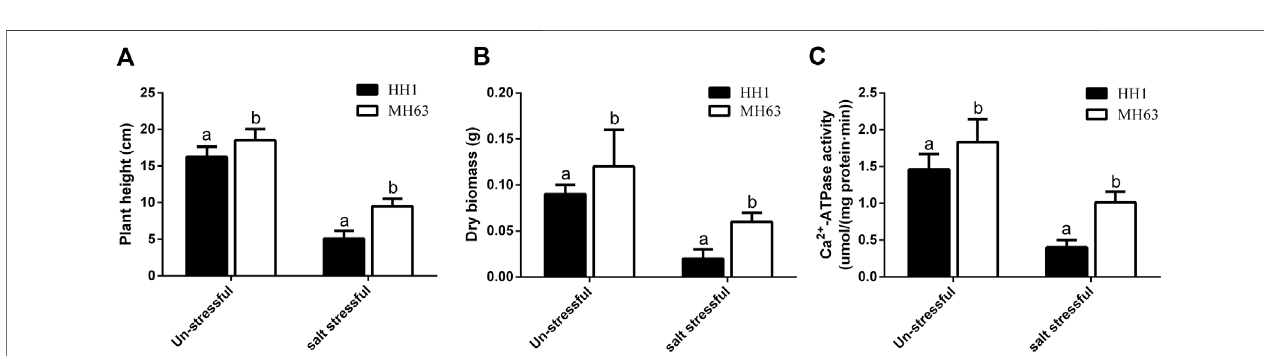
FIGURE 3 | Cry1Ab/c interacts with plasma membrane Ca 2+ -ATPase. (A) , Interaction between Cry1Ab/c-AD and Ca 2+ -ATPase-BD in Y2H Gold yeast cells was veri fi ed through yeast two-hybrid experiments. Y2H Gold yeast cells co-transformed with the indicated plasmids were spotted on quadruple dropout medium with X- α - gal (SD/ – Ade/ – His/ – Leu/ – Trp/X/A). Empty pGBKT7 (BD) and pGADT7 (AD) vectors were used as negative controls. (B) , Interaction between exogenous Cry1Ab/ c-cYFP and Ca 2+ -ATPase-nYFP fusion proteins in N. benthamiana mesophyll cells was veri fi ed through BiFC. YFP yellow fl uorescence was observed upon complementation of the Cry1Ab/c-cYFP and Ca 2+ -ATPase-nYFP fusion proteins. cYFP coexpressed with Ca 2+ -ATPase-nYFP and nYFP coexpressed with Cry1Ab/ c-cYFP were used as negative controls. 4A (NbeIF4A) plus P2 (RSV-encoded proteins) was used as the positive control. Red arrow indicates cell nuclei. scale bars: 50 μ m (C) , Interaction between exogenous Cry1Ab/c-mCherry and Ca 2+ -ATPase-GFP fusion proteins in N. benthamiana mesophyll cells was veri fi ed through co-IP. Proteinextracts(Input)wereimmunoprecipitatedwithGFP-trapagarosebeads(IP)andresolvedbySDS-PAGE.Theimmunoblotsshownweredevelopedwithanti-GFP antibody to detect Ca 2+ -ATPase-GFP fusion protein (54 kDa) and with anti-mCherry antibody to detect Cry1Ab/c-mCherry fusion protein (94 kDa). GFP empty vector plus Cry1Ab/c-mCherry was used as a negative control (27 kDa). “ * ” indicates the target band. The assays were repeated three times.